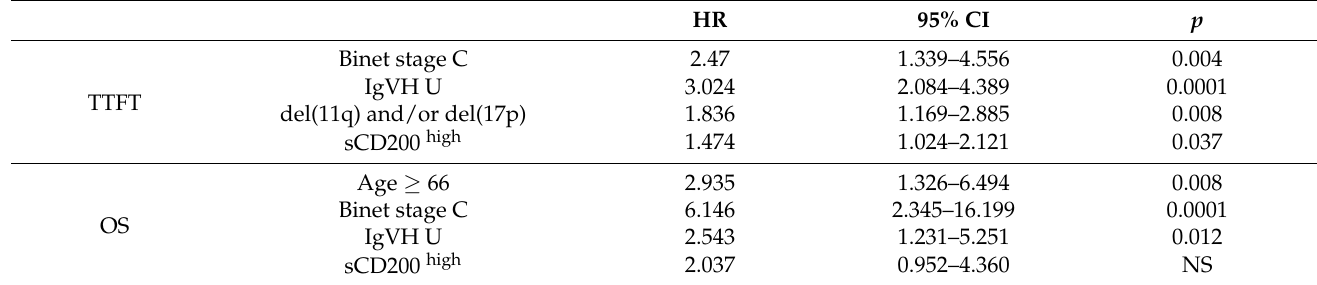
Table 3. Predictors of TTFT and OS in multivariate